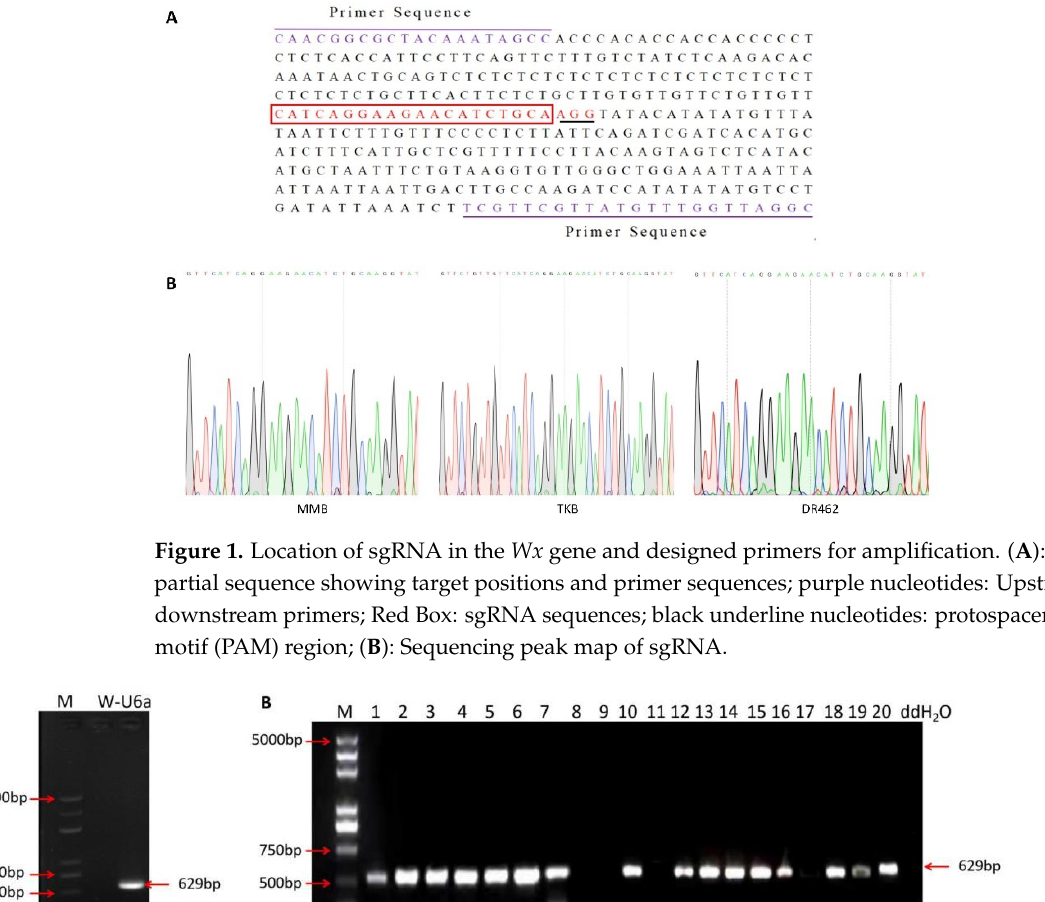
Figure 2. Construction of vector and verification of sgRNA. ( A ): Detection results of sgRNA expres- sion cassette; ( B ) Verification of the size of Wx gene cas9/sgRNA expression vector segment; M: DL 5000 DNA marker; W-u6a: sgRNA-u6a fragment; ddH 2 O is a negative control based on sterile water; 1–20 are the numbers of the positive clone bacterial solution picked at random; Lane 8, 9, 11, and 17 are empty plasmids; 5000 bp, 750 bp, 500 bp, 629 bp: fragment size.